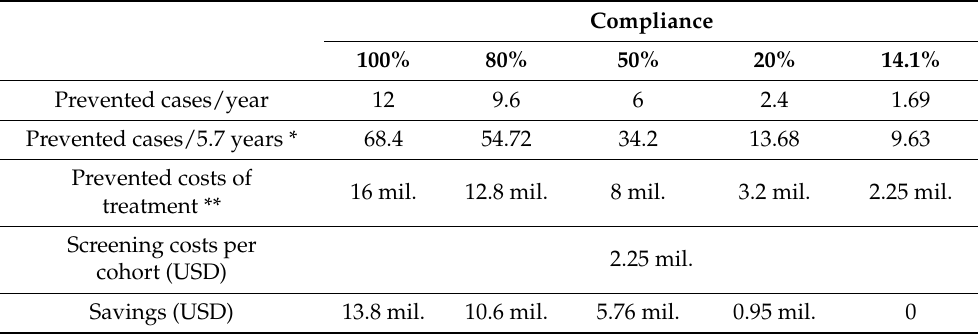
Table 3. Calculation of compliance and the number of prevented cases in the cohort of 50,000 women starting to take OCs every year in the Czech Republic. Compliance 100% 80% 50% 20% 14.1% Prevented cases/year